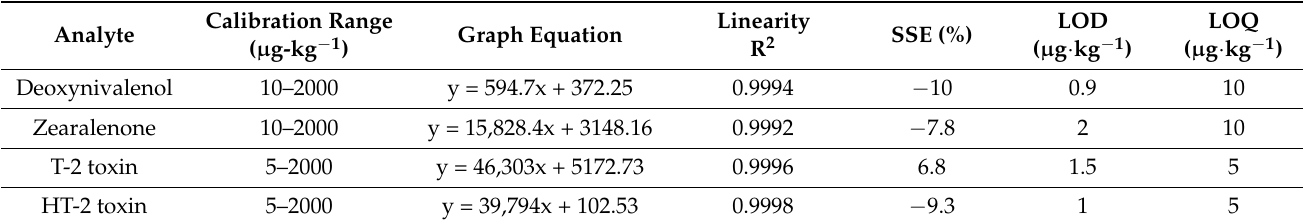
Table 3. Linearity data, limit of detection (LOD), limit of quantification (LOQ), and matrix effect (SSE) for tested compounds by LC-MS/MS.